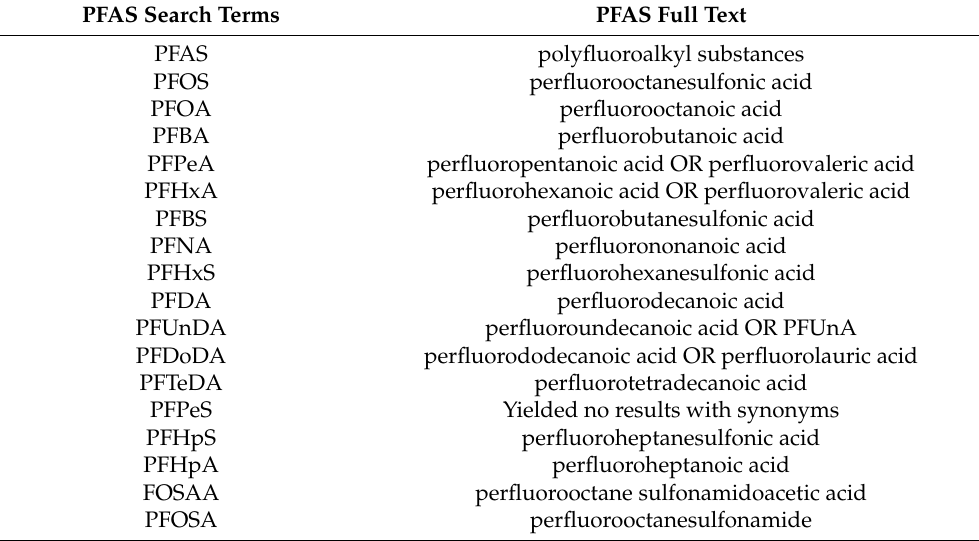
Table 1. Search Terms for PFAS species.